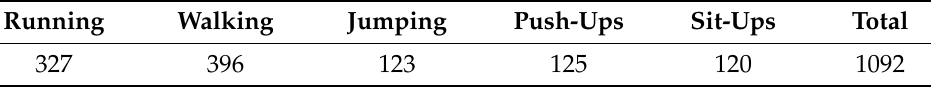
Table 1. Number of collected